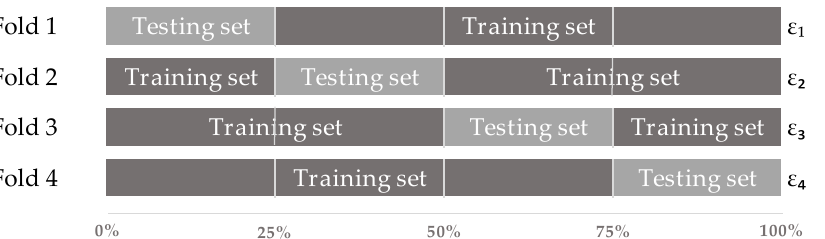
Figure 3. Four-fold Cross-Validation. The original dataset is partitioned into 4 equally sized subsets, which are repeatedly used as either test or training sets.